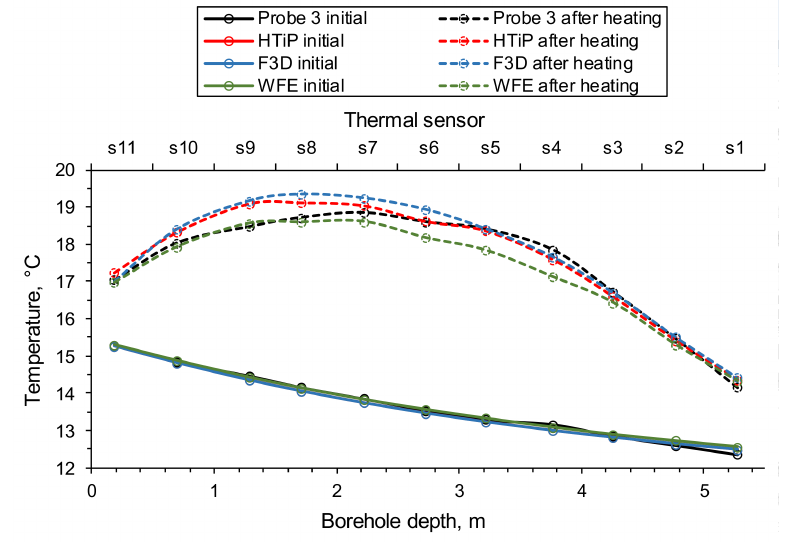
Figure 9. Comparison of the measured (black) and simulated rock temperatures at sensor locations along the monitoring borehole at the start and end of the heating phase for the HTiP, F3D, and WFE modelling approaches.